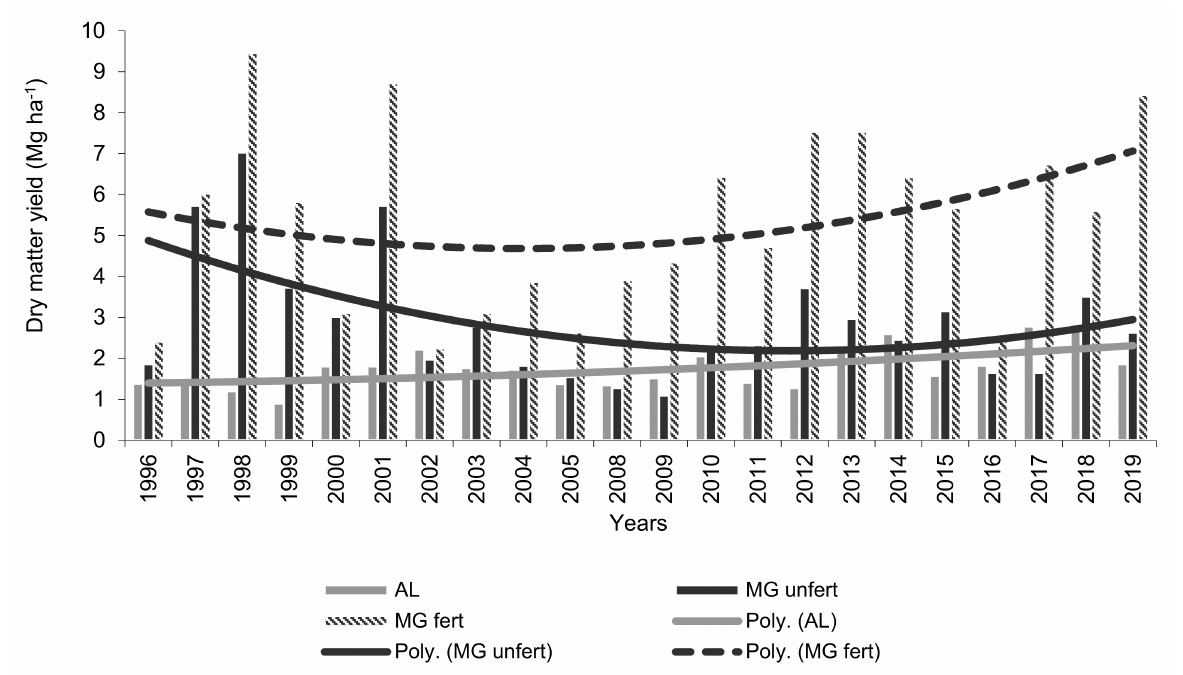
Figure 3. Long-term data detailing the biomass DM yield (Mg ha − 1 ) of grassland land uses in 1996–2019 and the regression line between 1996 and 2019. Note. Abbreviations: AL, abandoned land; MG unfert , managed unfertilized grassland; MG fert , managed fertilized grassland. AL and MG unfert subplots were unfertilized, MG fert subplot was